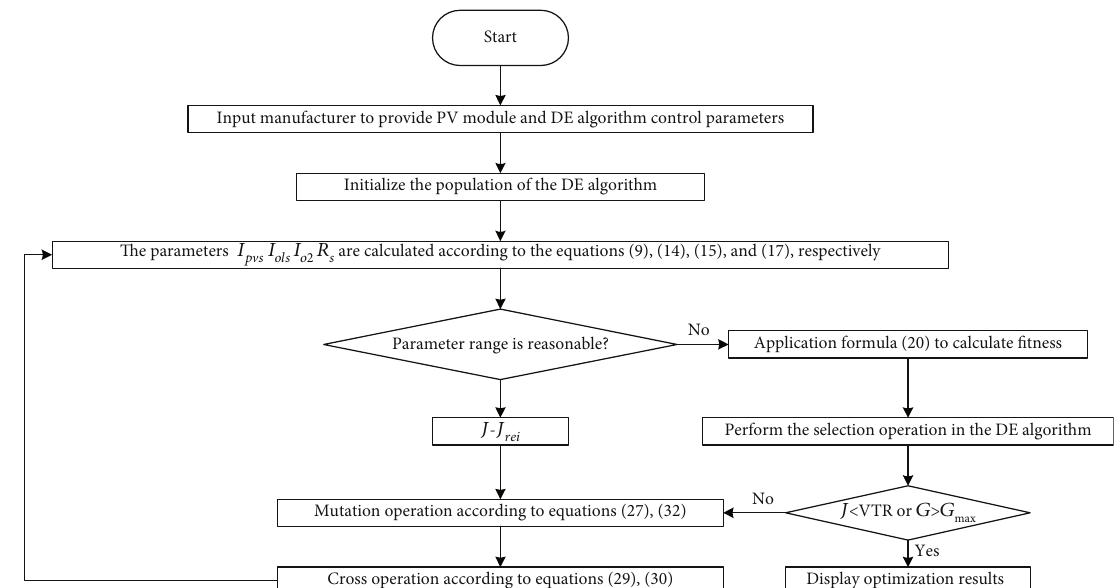
Figure 2: The algorithm fl ow chart proposed in this